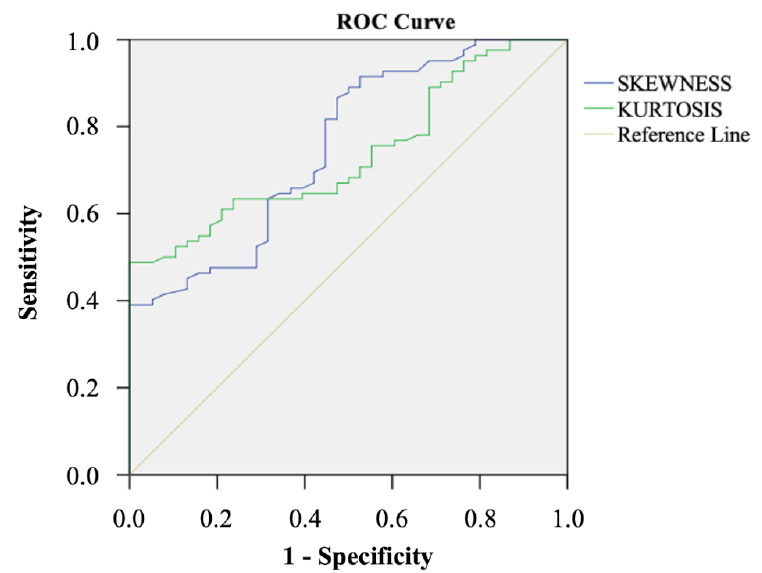
ROC curves (0.754 vs. 0.724; p = 0.89).